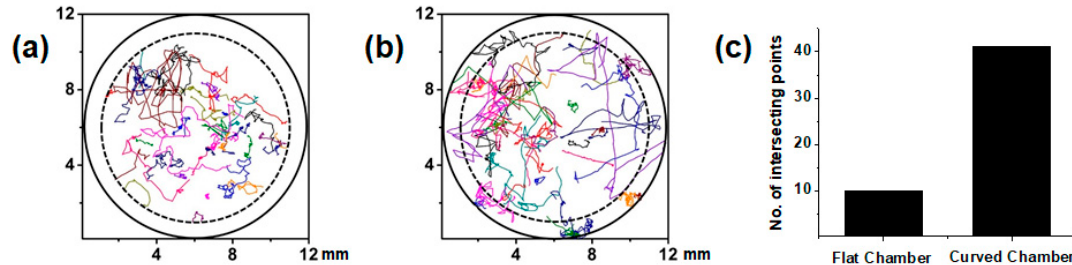
Figure 4. Trajectories from large-field flat and curved chamber image sequences. ( a ) The trajectories of the microswimmers moving in the flat chamber are trimmed at the edge of the image fields; ( b ) The trajectories of the microswimmers in the curved chamber are shown clearly even at the edge of the image field; and, ( c ) Comparison of the number of intersection points between the trajectories and inner circle of the 10 mm diameter dash line that is depicted in ( a , b ).